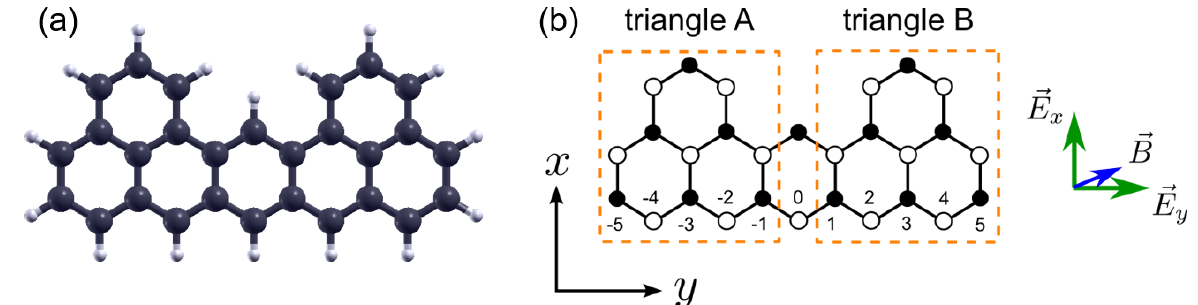
Figure 1. ( a ) View of the full heptauthrene nanostructure, consisting of carbon atoms (larger balls) and hydrogen atoms (smaller balls) [70]; ( b ) schematic view of the heptauthrene nanostructure with carbon atom positions marked with circles. Open and filled circles indicate the majority and minority carbon sublattice, respectively. Two triangles connected with a central dimer of carbon atoms are encircled with dashed lines. The labels of carbon sites at the longest zigzag edge are shown. The directions of in-plane electric fields and in-plane magnetic field are